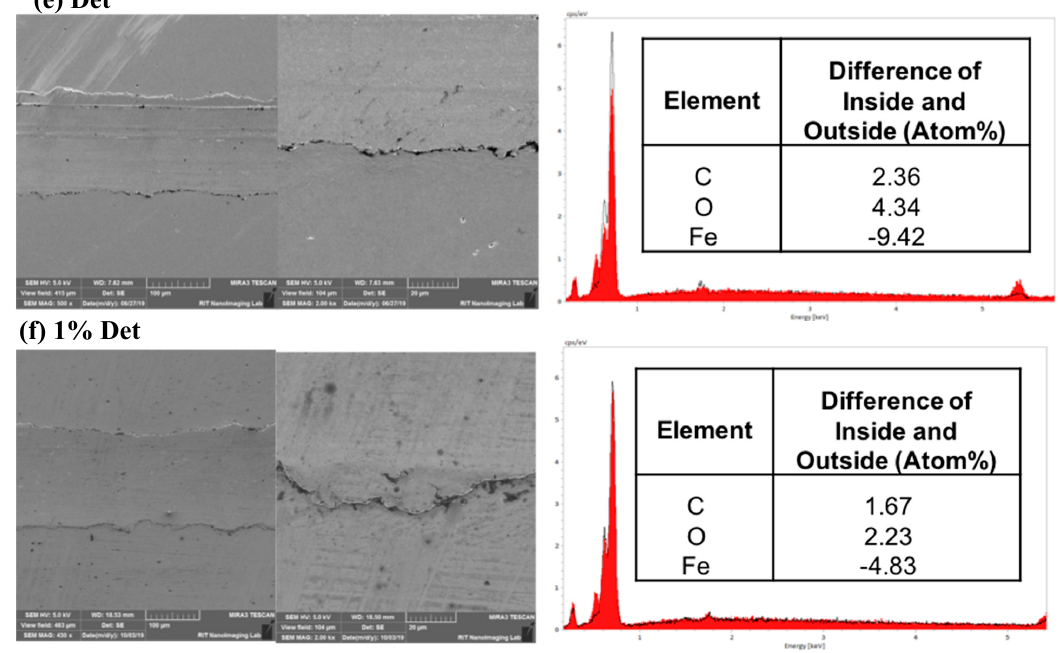
Figure 9. SEM images of worn surfaces and energy-dispersive X-ray (EDX) spectrum results of the inside and outside wear tracks for different lubricant conditions: ( a ) BO, ( b ) BOA, ( c ) Eet, ( d ) Met, ( e ) Det, and ( f ) 1 wt.% Det + BO.